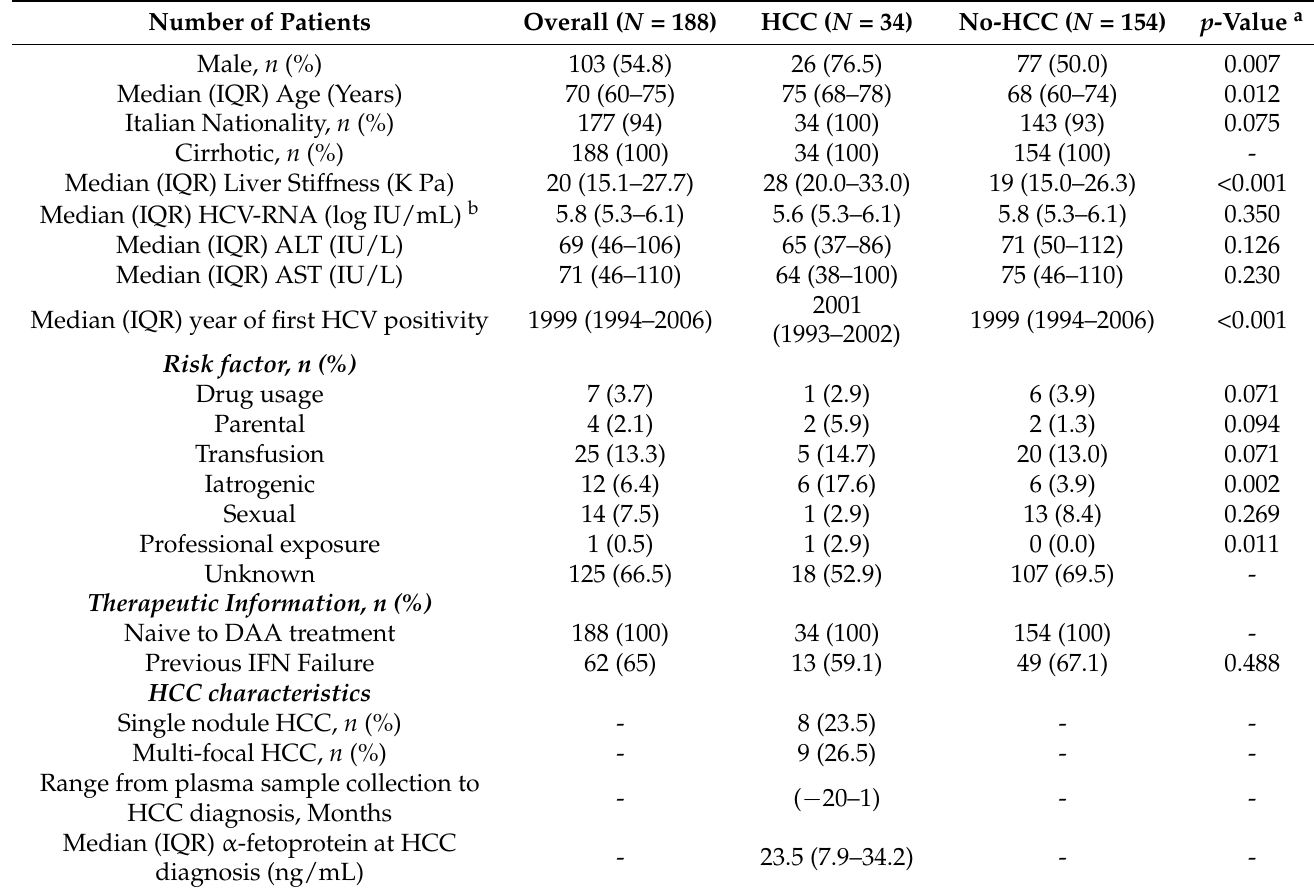
Table 1. Characteristics of the study population ( N =